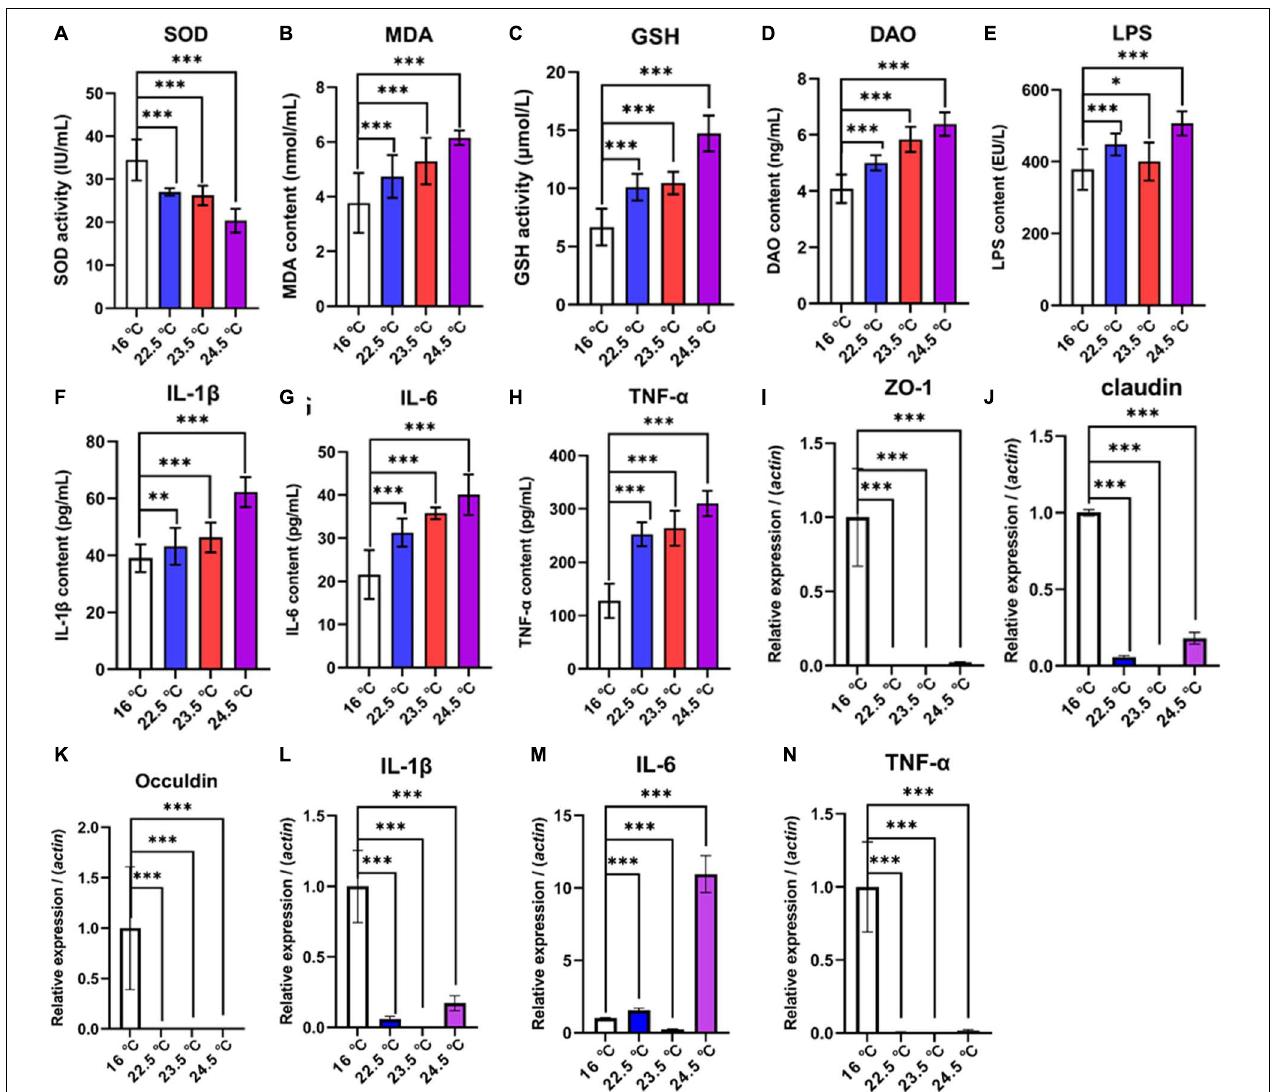
FIGURE 2 | Effects of acute heat exposure on intestinal barrier and antioxidant capacity. (A–C) the antioxidant capacity of intestinal contents was detected by enzyme linked immunosorbent assay (ELISA), which were SOD, MDA, and GSH, respectively. (D,E) DAO and LPS were used to detect intestinal permeability in serum by ELISA. (F–H) the levels of pro-inflammatory cytokines in serum were detected by ELISA, including IL-1 β , IL-6, and TNF- α , respectively. (I–K) expression of tight junction protein-related genes in mid gut were determined by quantitative real-time PCR, which were Zonula Occludens 1 ( ZO-1 ), Claudin , and Occludin , respectively. (L–N) expression of pro-inflammatory cytokines related genes in mid gut were determined by quantitative real-time PCR, which were IL-1 β , IL-6, and TNF- α , respectively. The reference gene is β -actin. Bars represent geometric means ± standard deviation. N = 3 biological replicates (average of triplicate technical replicate per biological replicate). ∗ , P < 0.05; ∗∗ , P < 0.01; ∗∗∗ , P < 0.001 using a one-way analysis of variance (ANOVA) followed by Tukey’s HSD